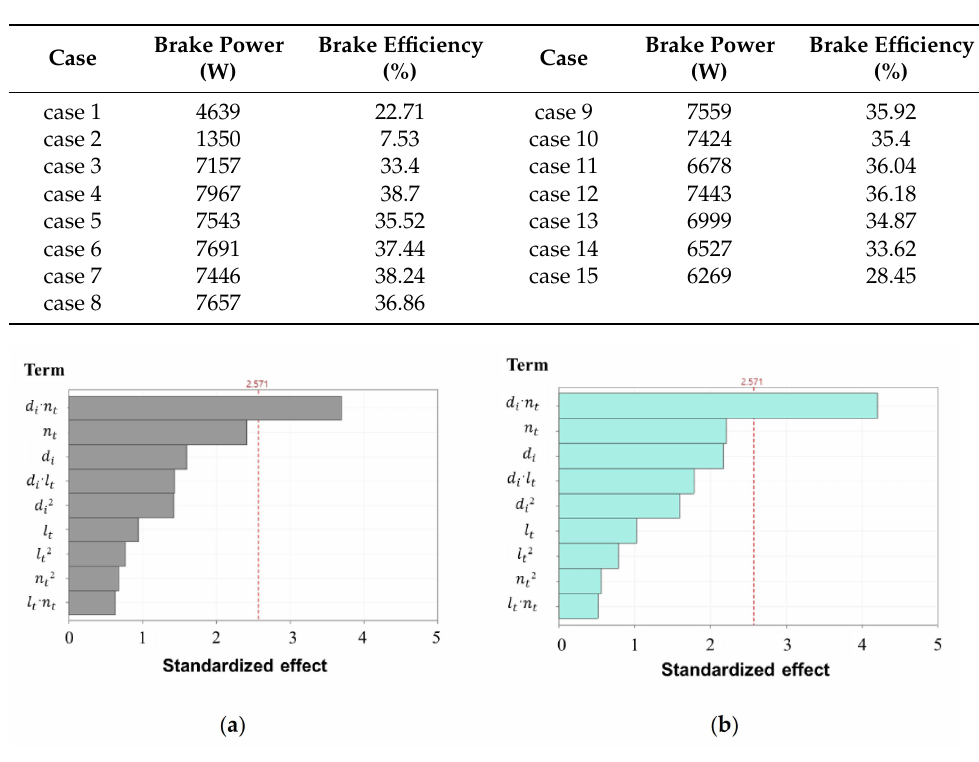
Table 11. Results of the CCD case.